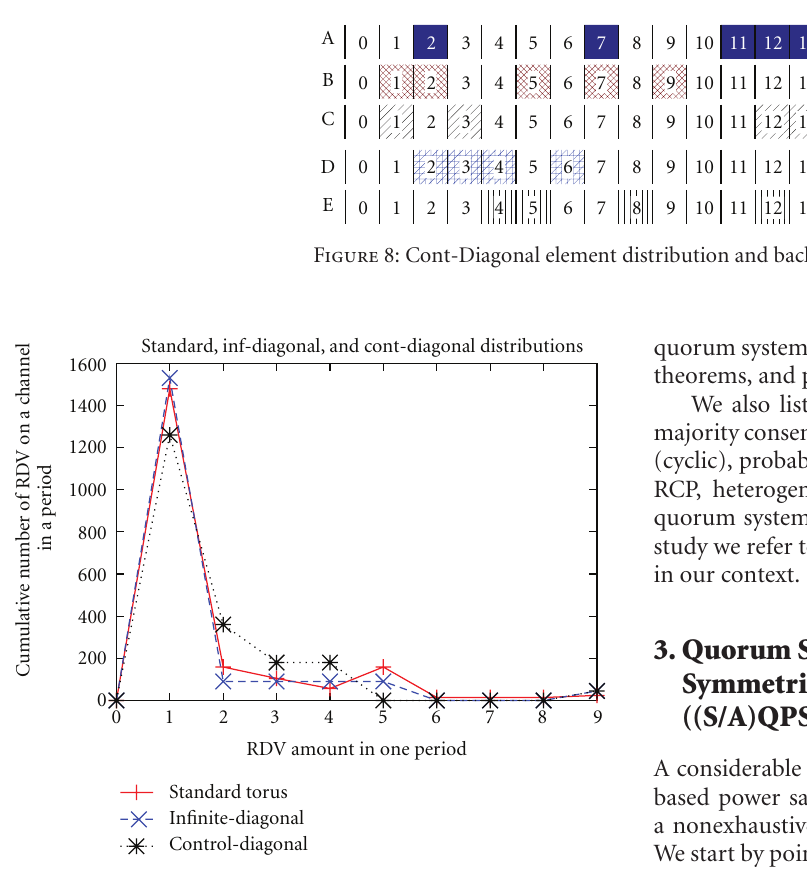
Figure 9: Standard, inf-Diagonal, and cont-Diagonal intersection